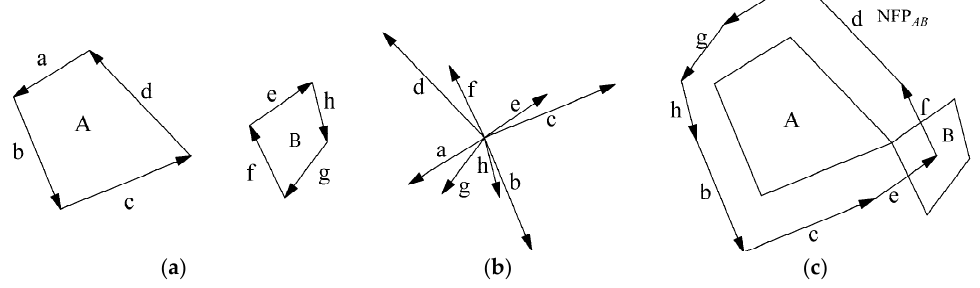
Figure 2. Method of generating a no-fit polygon with convex polygons. ( a ) Polygons A and B ; ( b ) All edges are moved to a single point; ( c ) Generation of NFP AB